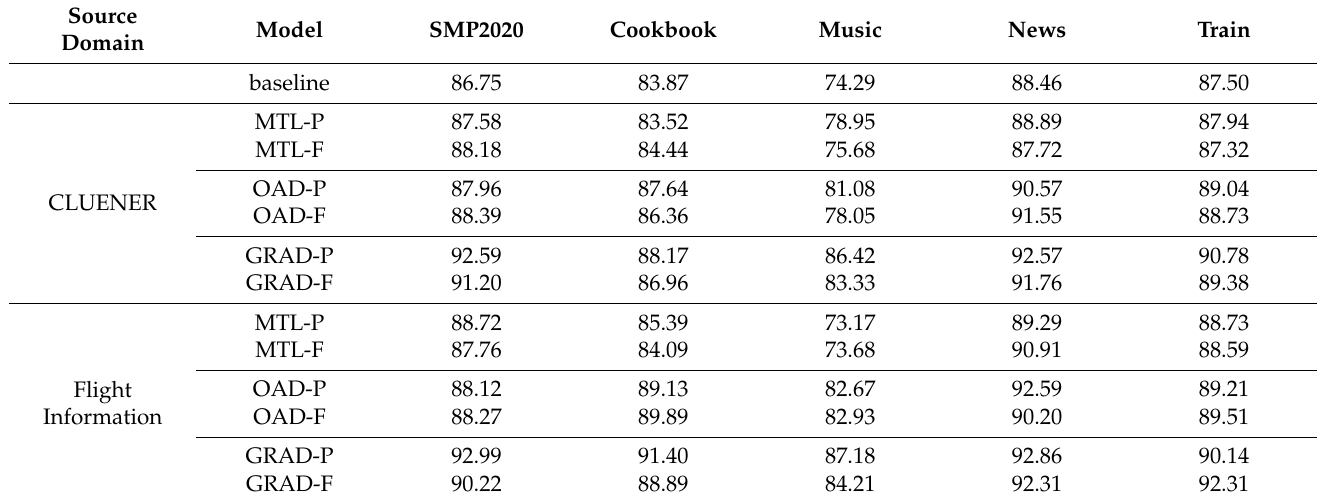
Table 3. Experimental results of NER for spoken language understanding using transfer learning